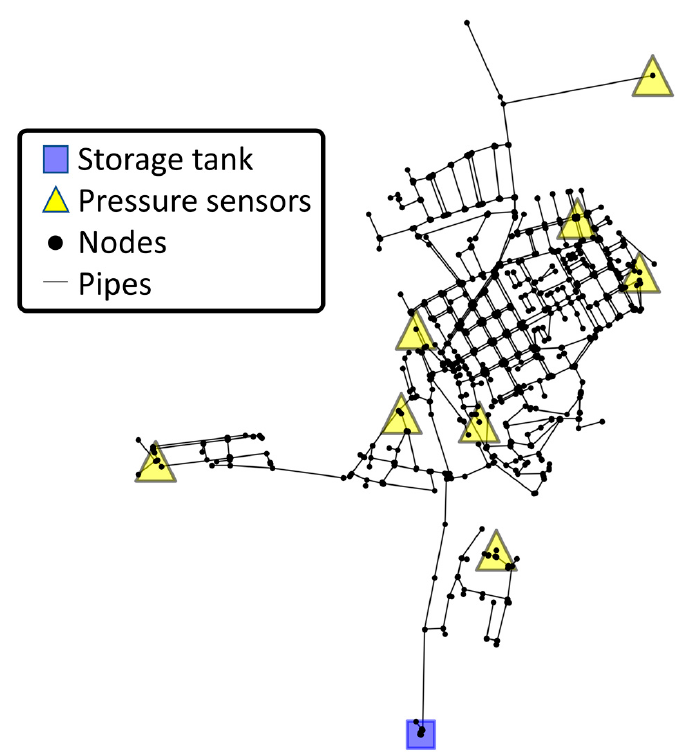
Figure 5. Case study of WDN displaying monitoring sensors and inlets.